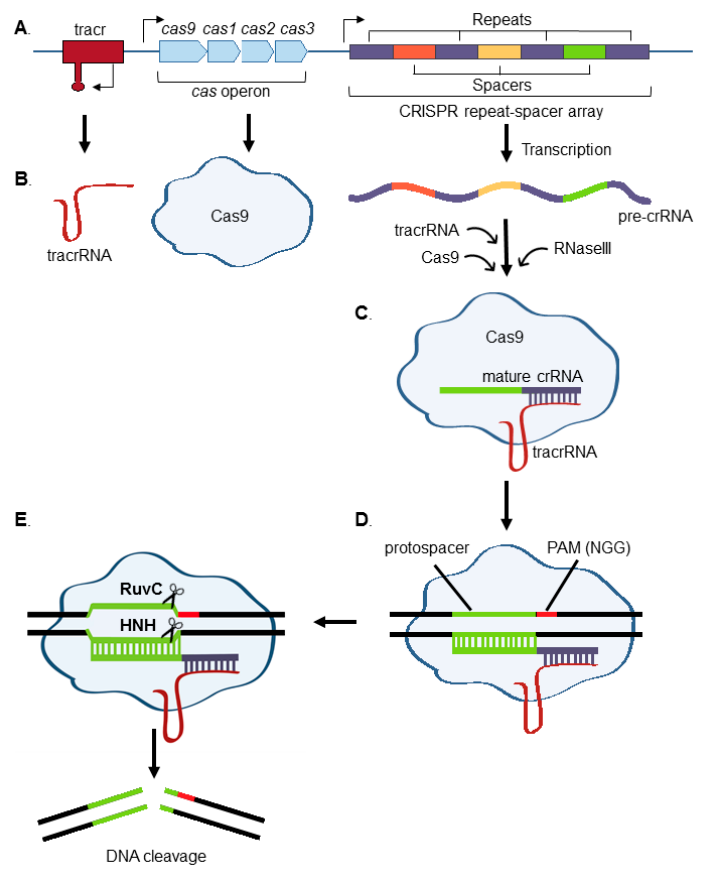
Figure 1. Type II CRISPR–Cas9 overview. ( A ) Key components of the Streptococcus pyogenes CRISPR–Cas system are shown. These include the trans-activating crRNA (tracr) locus, cas gene operon, and CRISPR repeat-spacer array; ( B ) the CRISPR repeat-spacer array is transcribed into pre-crRNA, which includes archived spacer sequence derived from foreign DNA. The pre-crRNA transcript is cleaved and processed into a single spacer-repeat sequence by a complex of RNaseIII, tracrRNA, and Cas9;